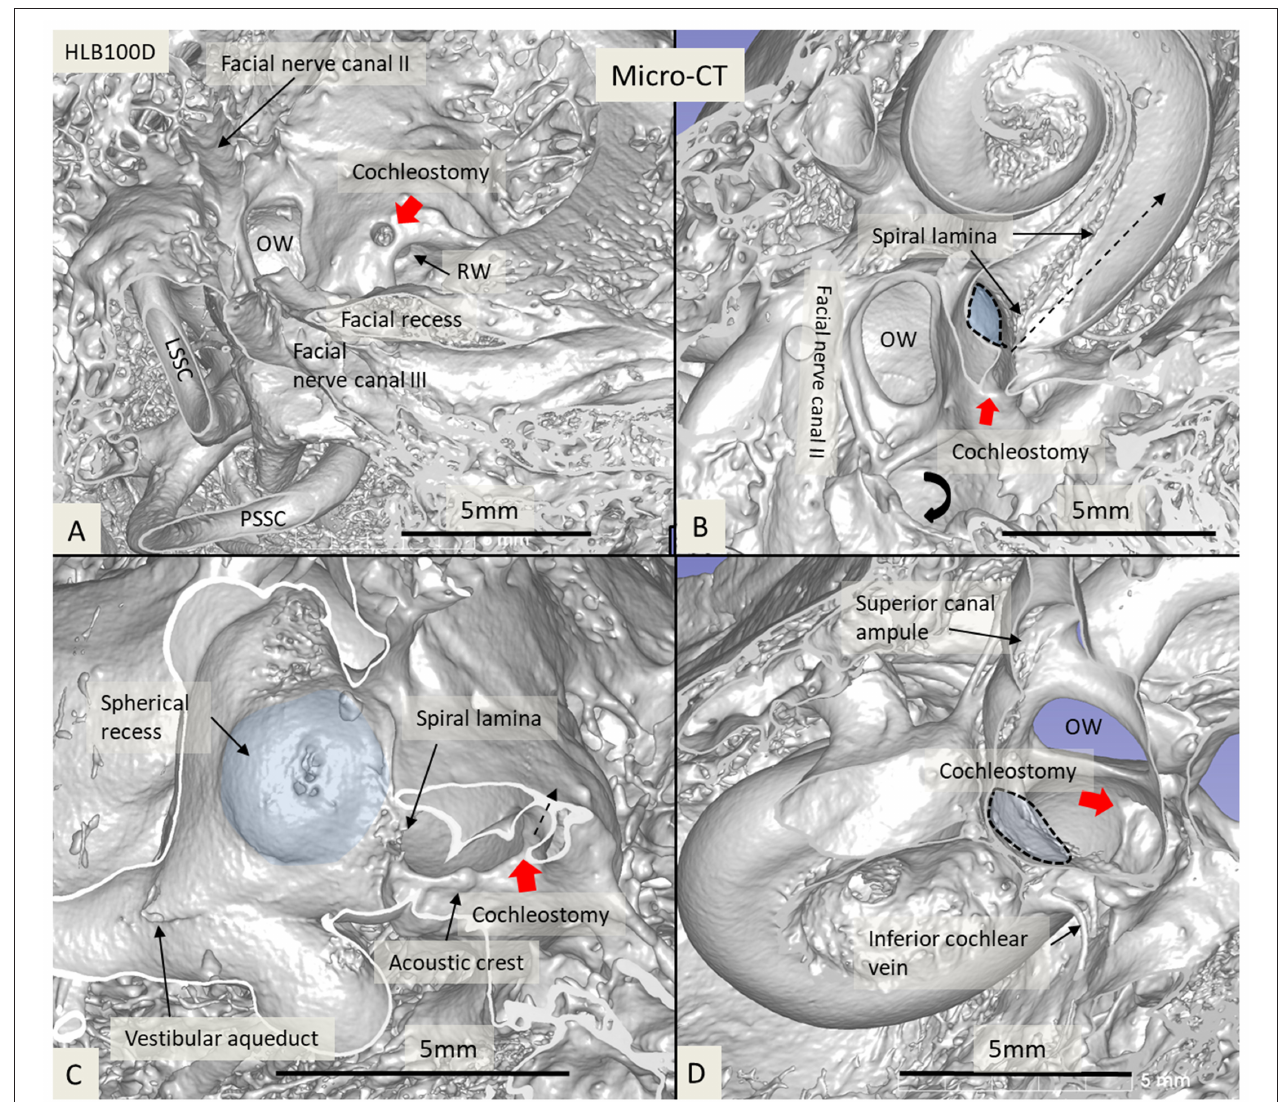
FIGURE 6 | Micro-CT and 3D reconstruction of a macerated human temporal bone (right ear). An anterior CO was made (red arrow), and its relation to the spherical recess (blue) and saccule was studied. (A) Surgical view shows the CO and the RW. (B) Lateral cropping demonstrates the entrance canal of the CO and its relation to the spherical recess. The bold arrow shows the tympanic sinus. (C) Medial cropping shows the spherical recess (blue) with bony foramina of the saccular nerve. The broken arrow shows the direction of the scala tympani. (D) Medial view shows CO and spherical recess (dashed line). OW, oval window; RW, round window; LSSC, lateral semicircular canal; PSSC, posterior semicircular